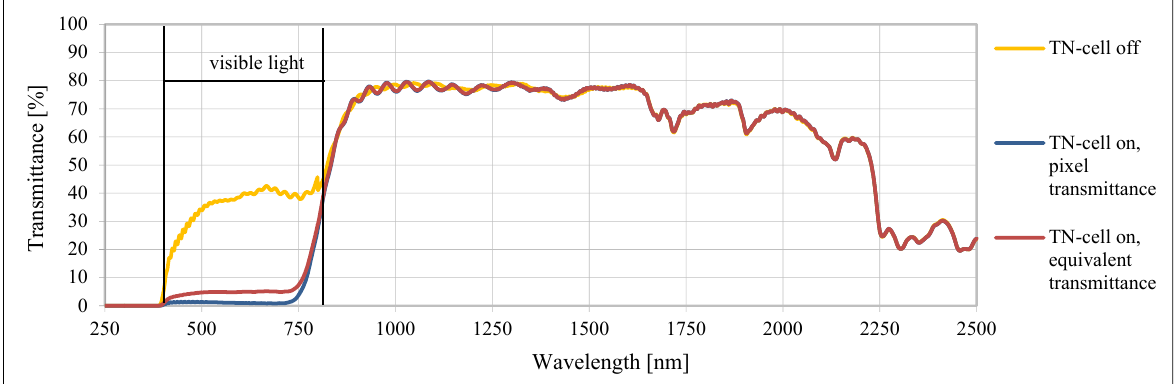
Fig. 1 Spectral transmittance of an unstructured TN-cell with external